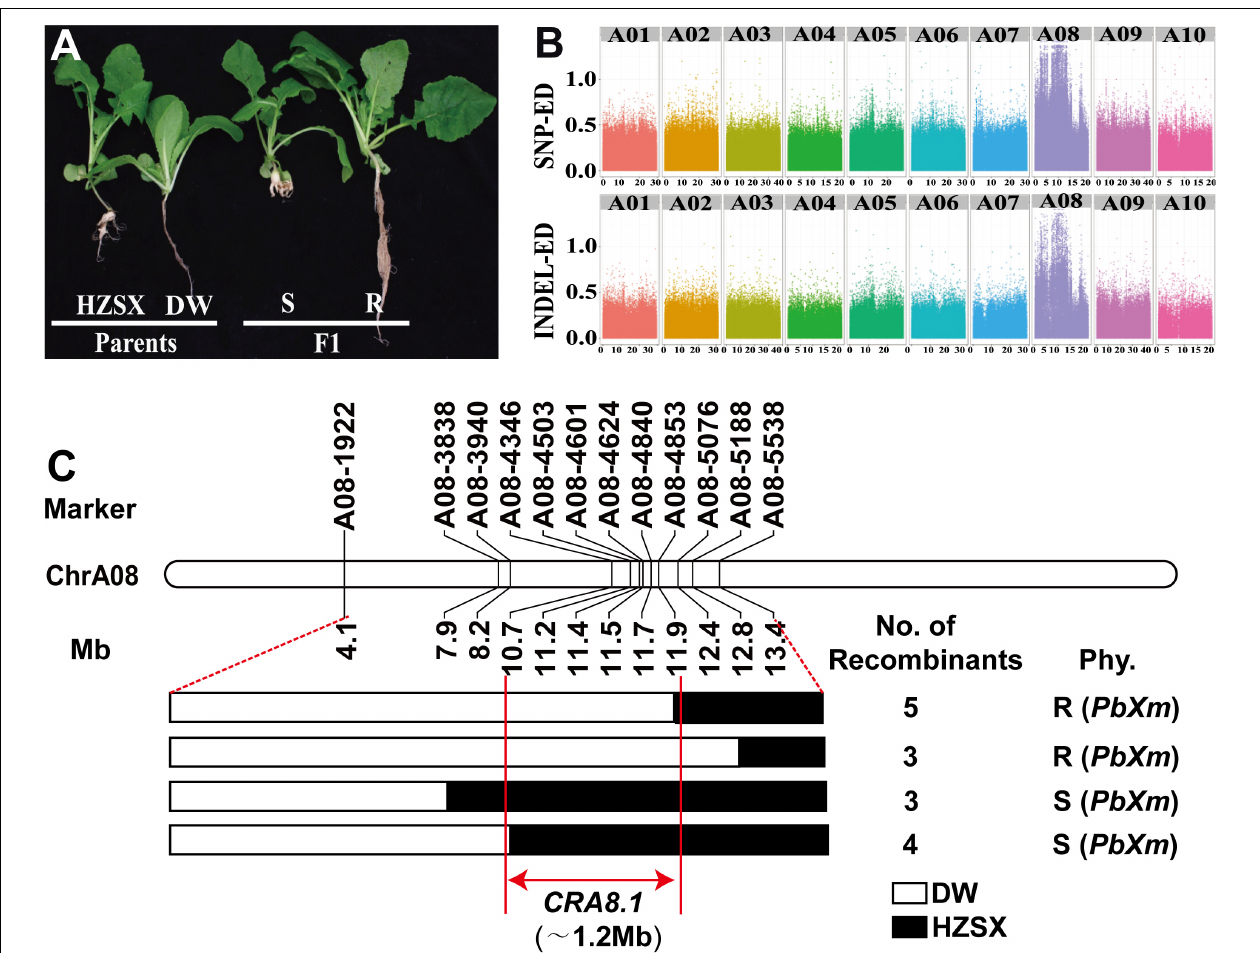
FIGURE 2 | Primary mapping of CRA8.1 in B. rapa . (A) Root phenotypes of DW, HZSX, and F 1 after inoculation with PbXm . S, susceptible; R, resistant. (B) The Euclidean distance (ED) values of SNPs and InDels on chromosomes from the A genome. (C) Fine mapping of CRA8.1 region with InDel markers. Fifteen recombinants were identified from F 1 population from markers A08-1922 to A08-5538. Black or white represents the regions found in HZSX or DW, respectively. Red lines indicate the CRA8.1 locus (1.2 Mb) identified from this